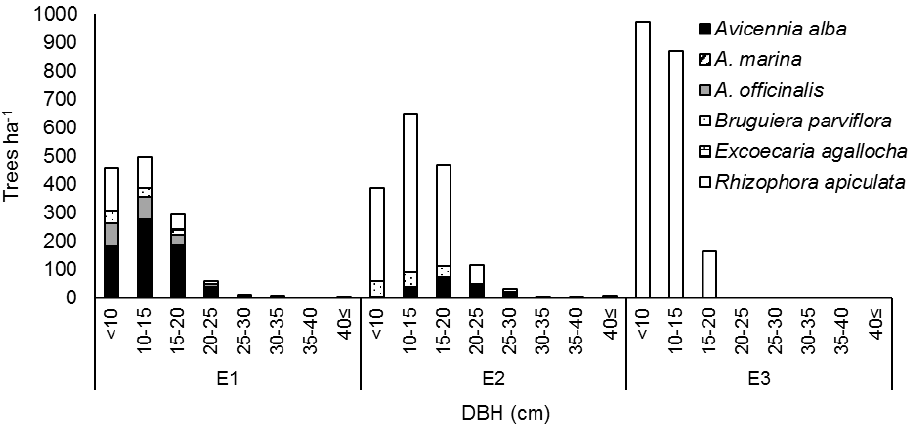
Figure 5. DBH distribution of trees ≥ 6 cm DBH by species for groups E1, E2, and E3 in erosion sites. Plots belonging to each group are shown in Figure 2.